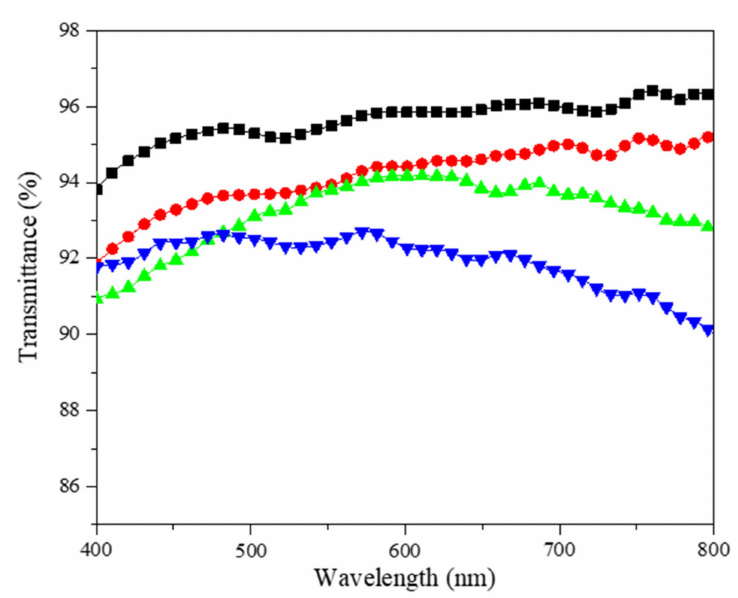
Figure 9. Transformation in transmittance of C-P film. Before spray simulation (- (cid:4) -); spray simulation for 2 min (- • -); for 4 min (- (cid:78) -); for 6 min (- (cid:72)